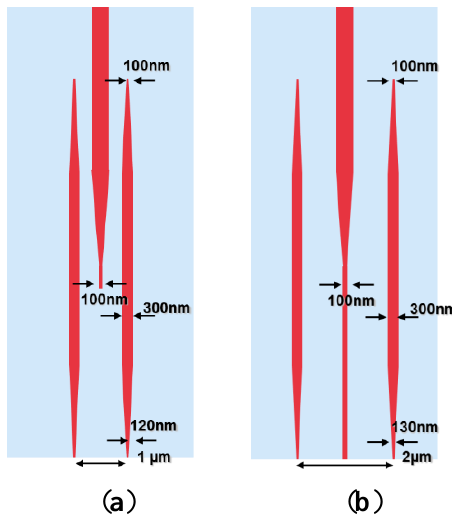
Figure 5. Spot size convertor structures for a 1.3 μm wavelength QD LD. ( a ) Trident spot size convertors (SSC). ( b ) Triple-core